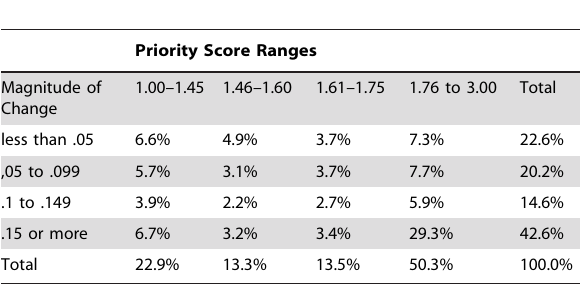
Table 2. Magnitude of Change from Preliminary Priority Score to Final Priority Score by Defined Ranges.